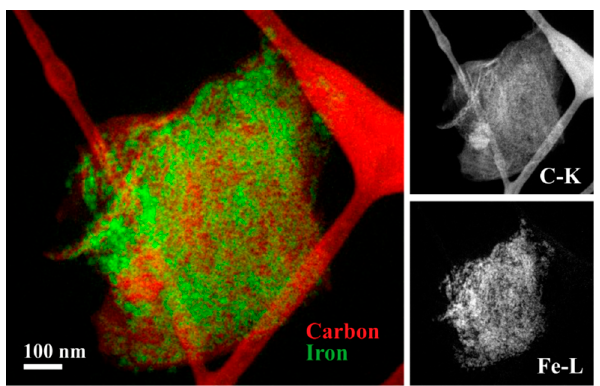
Figure 2. EFTEM elemental distribution maps of carbon and iron in the SPION-RGO composites.